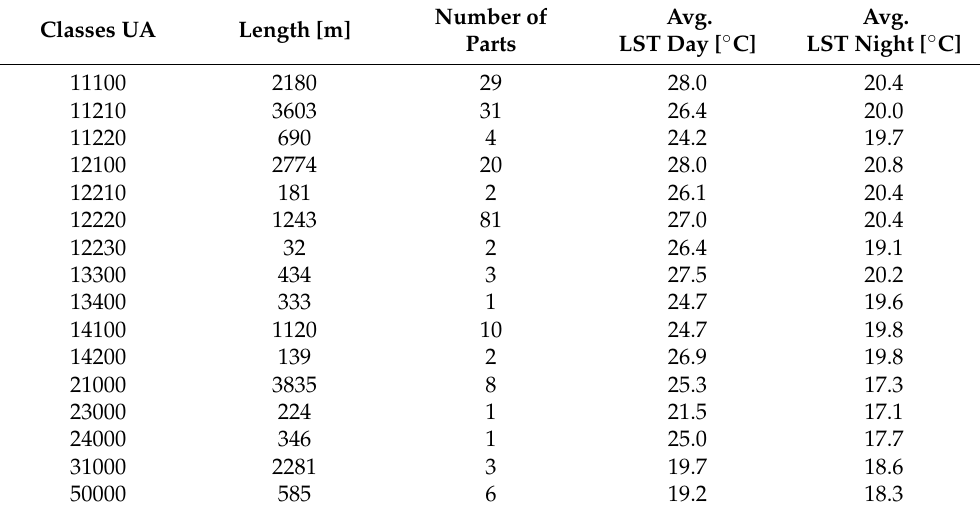
Table 2. Urban Atlas Landscape Cover Classes in the profile section of Bratislava and average day and night-time surface